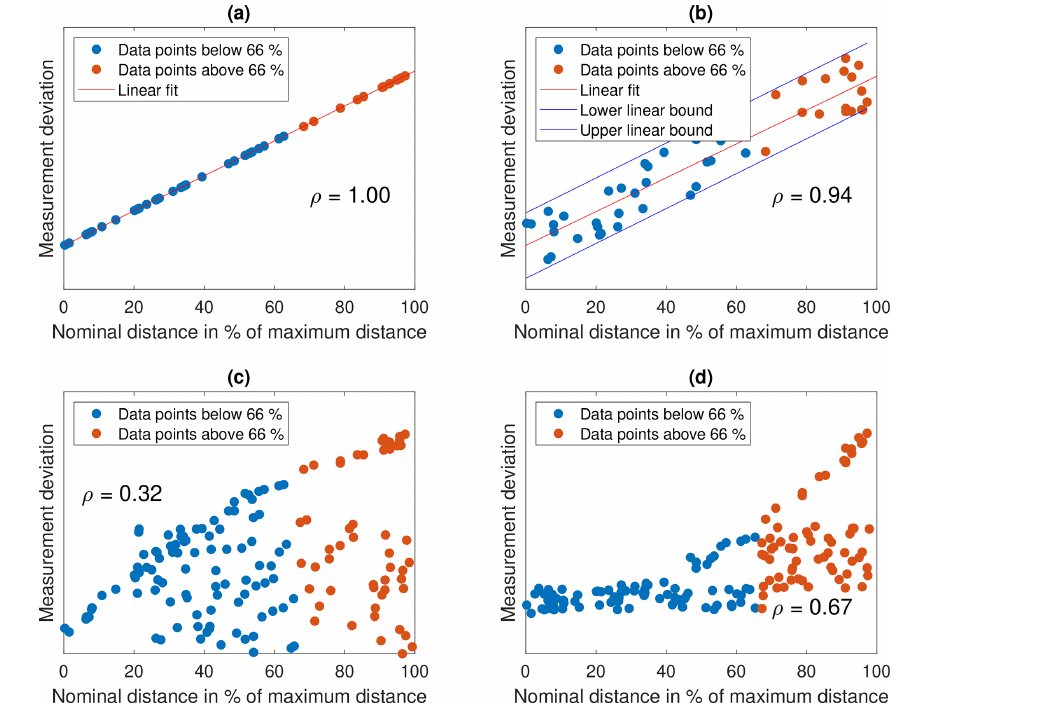
Figure 1. Four different patterns for the SD errors can be imagined. The pattern in plot (a) illustrates strictly linear behaviour, indicated by a correlation coefficient of ρ = 1. The pattern in plot (b) illustrates a behaviour that is roughly linear in the sense that there are two parallel linear functions within which all data points lie. The pattern in plot (c) illustrates an increase that is less than linear; i.e., the increase of the measurement deviation with the nominal length is less than linear. The pattern in plot (d) indicates more than linear behaviour. This latter behaviour is the only one we would deem relevant for the MPE specification as an MPE limit constructed using points up to a certain percentage might easily be exceeded by points at a higher percentage. The plots show that while the correlation coefficient ρ can detect strictly linear behaviour, it is not sufficient for deciding whether or not a given pattern would be relevant regarding the MPE